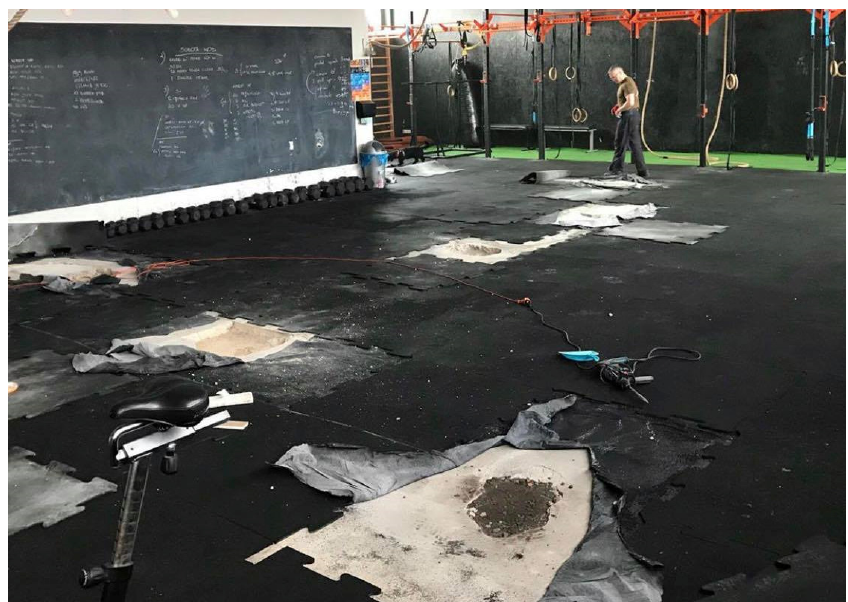
Figure 1. Destroyed fitness center floor.